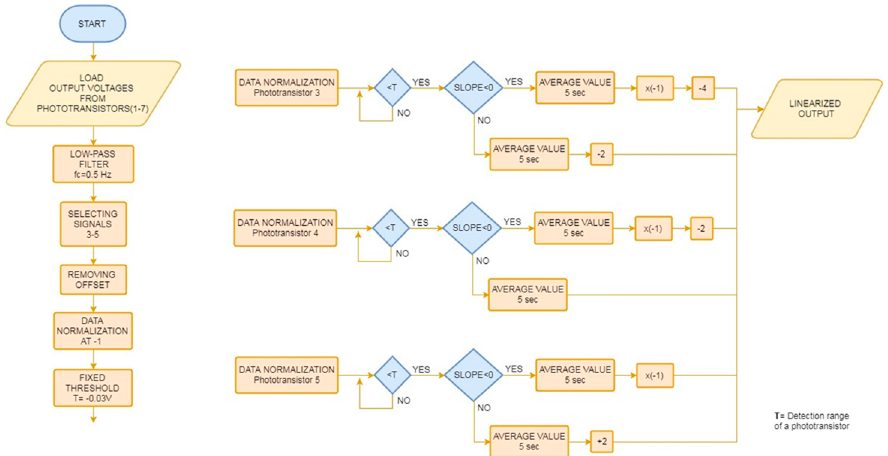
Figure 2. Signal processing paradigm. For the sake of simplicity and due to the system symmetry, the scheme takes into account only a subset of IR detectors.